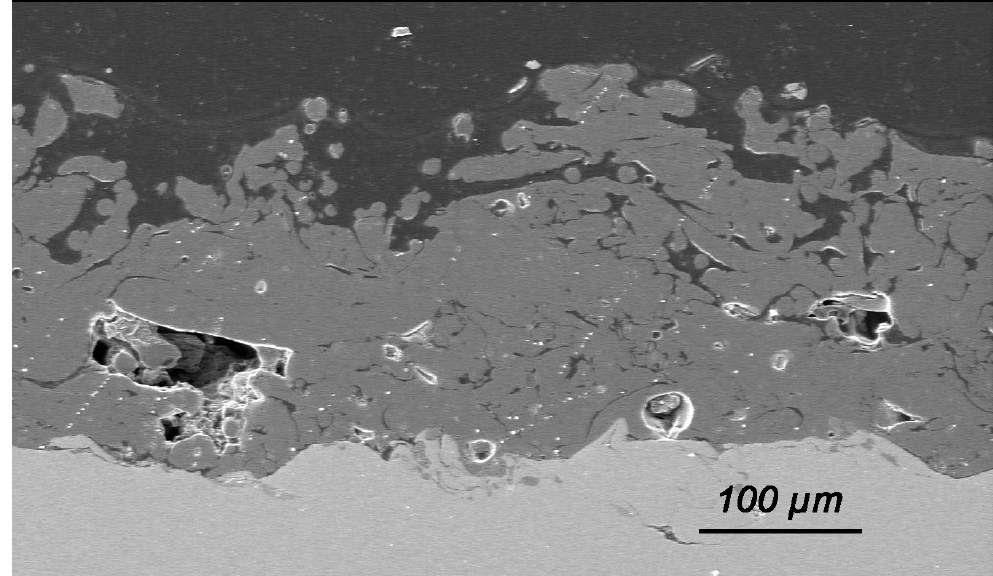
Figure 5. The cross-section of Thermal spray zinc (TSZ) coating. The very rough microstructure affects the conductivity of the coating, which results in a very large variation in paint film thickness measurements with Eddy current gauge.